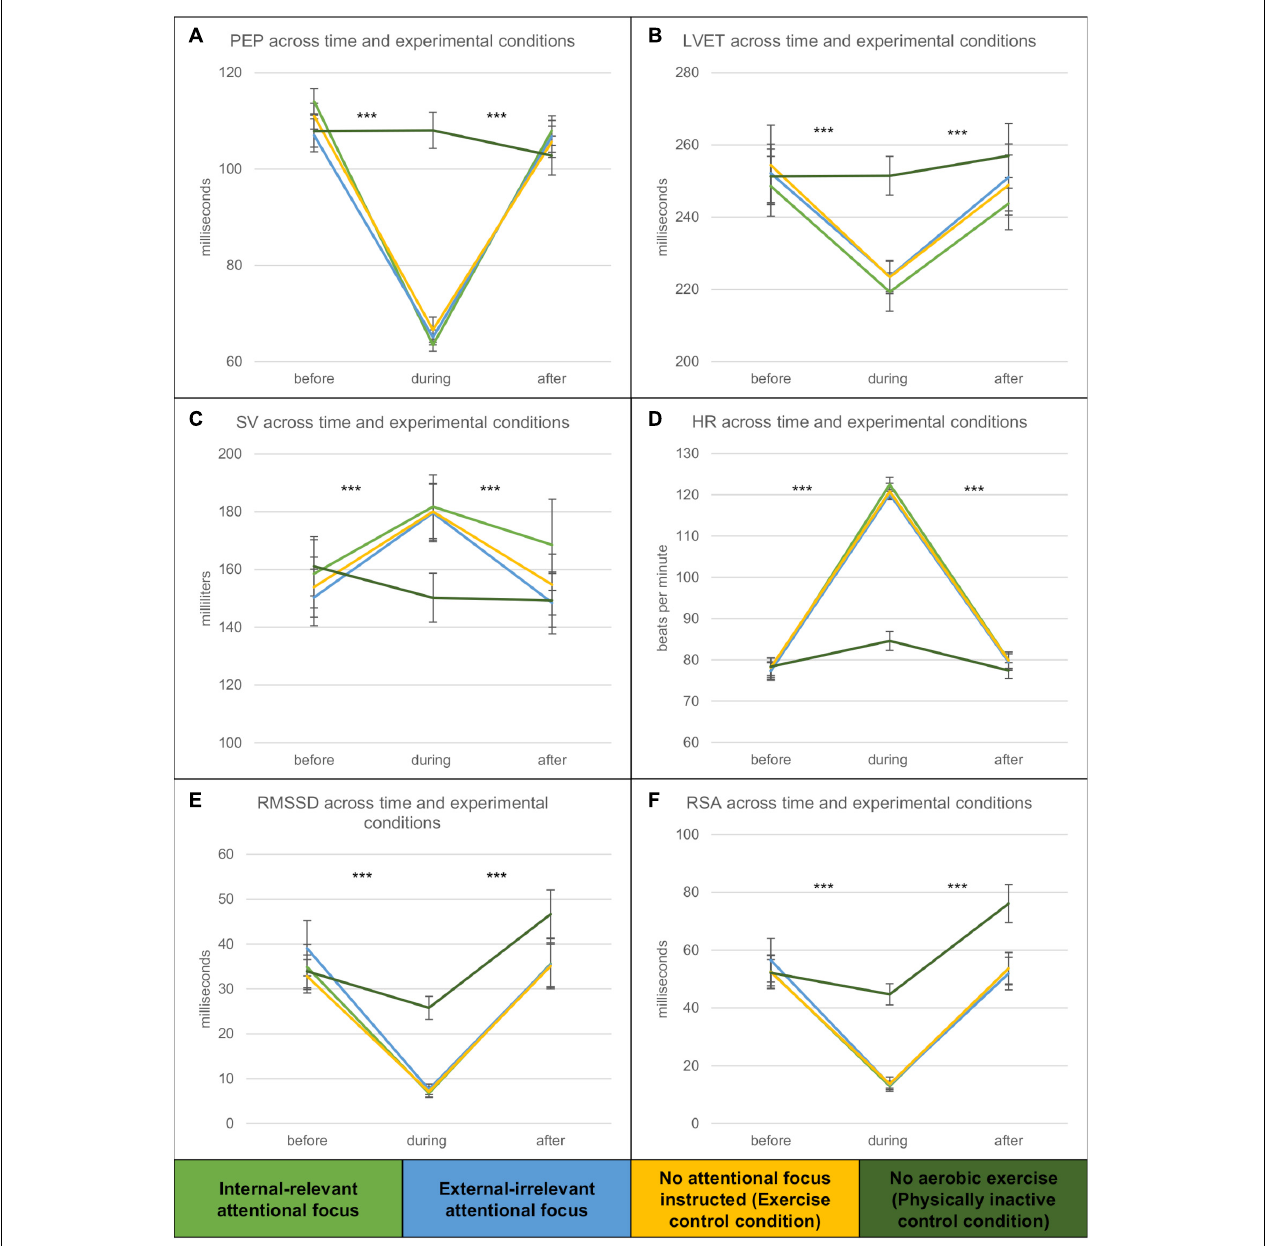
FIGURE 3 | (A–F) Changes in PEP (ms), LVET (ms), SV (cm 3 /ml), HR (bpm), RMSSD (ms), and RSA (ms) across time (before, during and + 10min after the (in-) activity) and experimental conditions. Asterisks indicate significant differences between time points, regardless of exercise condition (* p < 0.05; ** p <